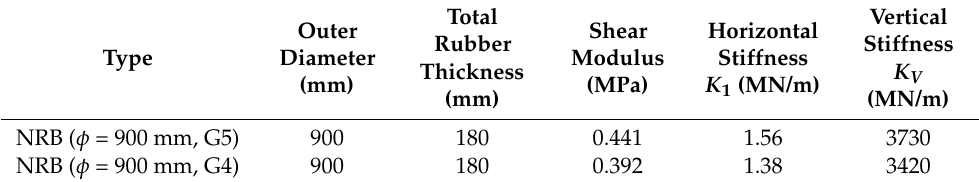
Table 2. Properties of the selected natural rubber bearings (NRBs).